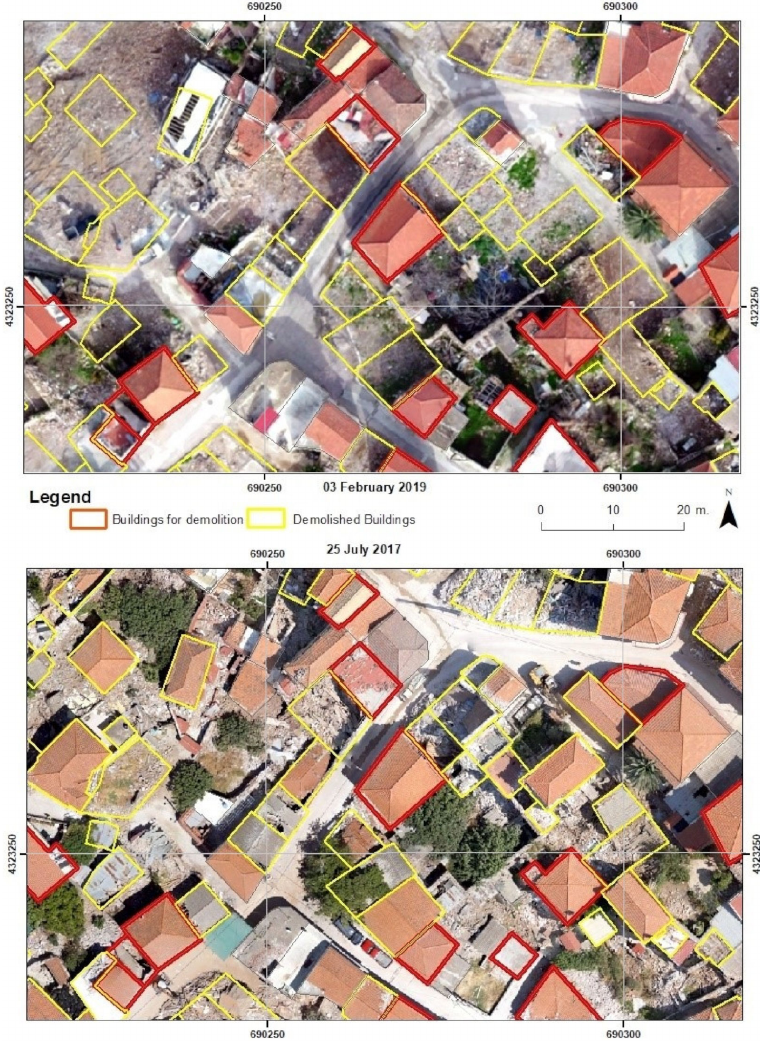
Figure 6. The top orthophoto map of 3rd February 2019 derived from UAS 4K-video footage presents the demolished buildings mapped by photo interpretation and fieldwork. The bottom orthophoto map of 25th July 2017, derived by UAS high resolution images, presents the buildings which have been approved for demolition by the